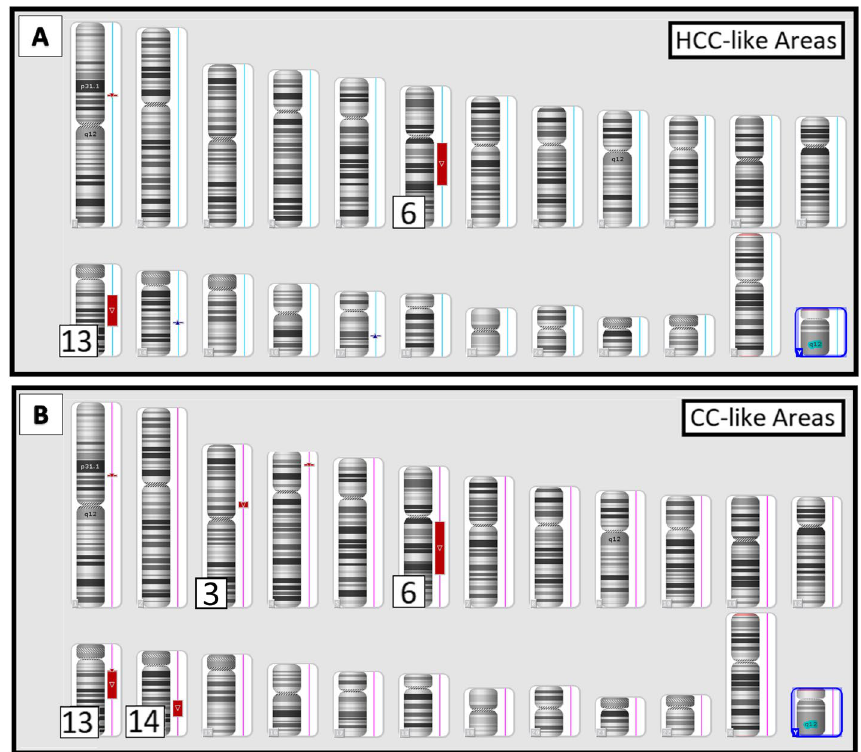
Fig. 5 Chromosomal microarray (CMA) was performed on the histologically HCC-like ( A ) and histologically CC-like ( B ) areas. Both areas revealed large deletions (red bars) in chromosomes 6q and 13q and the CC-like component revealed additional large deletions in chromosomes 3p and 14q. The results favor that the neoplastic cells arose from a single clone with genetic heterogeneity causing the tumor’s histologic